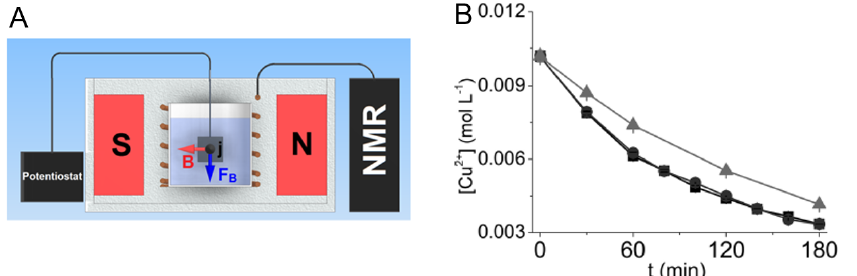
Figure 5. ( A ) Illustration of the electrochemical cell inserted in the NMR relaxometer. ( B ) Variation of Cu 2 + concentration as a function of electrolysis time performed in the electrochemical cell recorded at 23 ○ C under different configurations: ( ∎ ) B ⊥ j , ( ● ) B ∥ j , and ( ▲ ) B = 0. Solution: 0.1 mol ⋅ L − 1 Na 2 SO 4 electrolyte containing 0.01 mol ⋅ L − 1 CuSO 4 . Conditions: E applied = − 0.4 V vs. Ag/AgCl (3 mol ⋅ L − 1 KCl). The Cu 2 + concentration data were determined by CPMG pulse sequence. The standard error is represented by the error bars ( n = 3). Adapted with permission from [8]. Copyright (2014) American Chemical